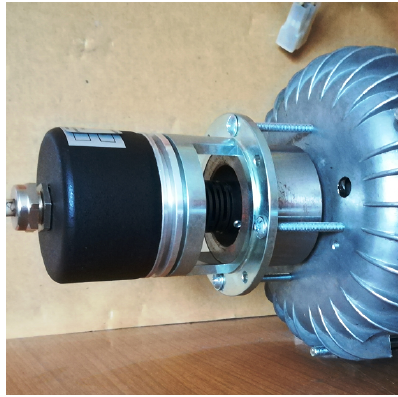
Figure 10. Digital encoder—optional variant of determining the position of the motor shaft.